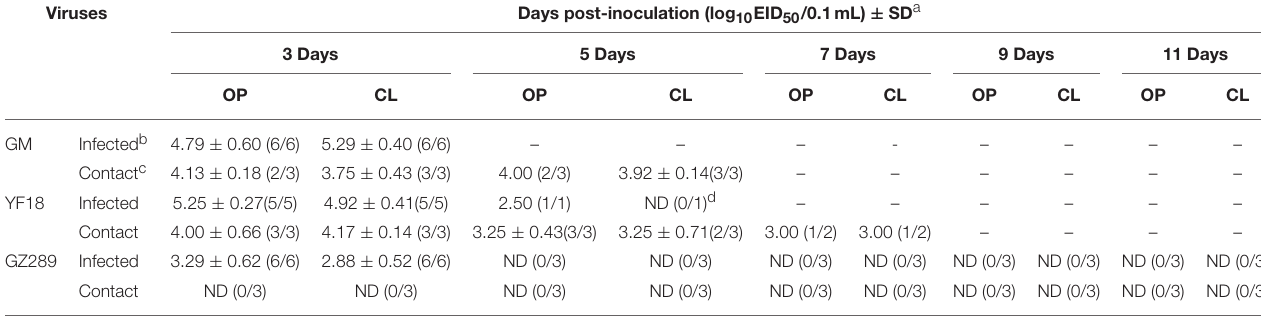
TABLE 3 | Virus titers in oraopharyngeal and cloacal swabs from chickens.